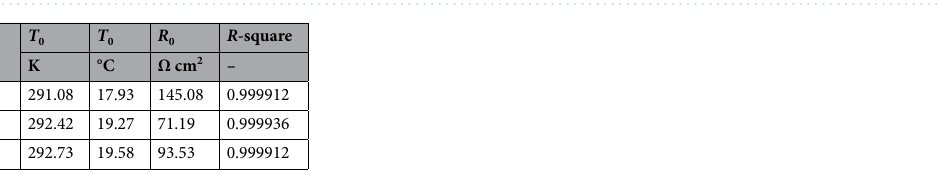
Table 5. Optimal adjustable parameters’ values of Eq. (14), for each acid.